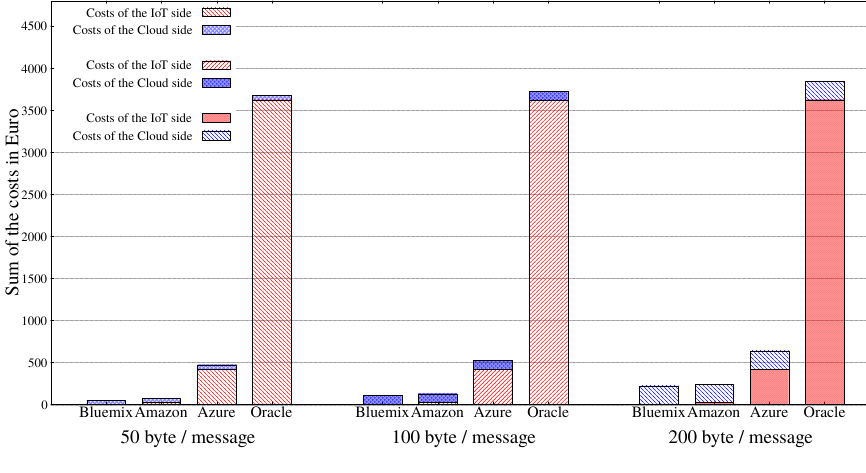
Figure 8. IoT and cloud costs in scenario N o 1. Table 1. Used VMs, number of task and produced data in scenario N o 1.